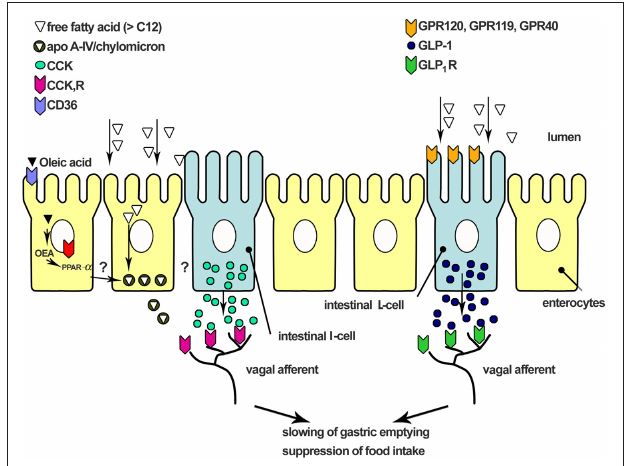
Figure 1 | Schematic representation of the mechanisms involved in small intestinal fat sensing. Fatty acids are sensed by G-protein coupled receptors (e.g., GPR40, GPR120, and GPR119) located on enteroendocrine cells. These GPCRs appear to mediate gut peptide secretion induced by small intestinal fatty acids. Uptake of fatty acids into the enterocyte is mediated by the receptor CD36. This receptor is critical for the mobilization of oleoylethanolamine (OEA), which has been shown to reduce food intake and body weight via the activation of the nuclear receptor, peroxisome-proliferator- activated receptor- α (PPAR- α ). Long chain fatty acids also stimulate chylomicron formation, and, in particular, the chylomicron component apolipoprotein A-IV (apo A-IV), is important in mediating CCK secretion and the effects of long-chain fatty acids on energy intake. The gut peptides released, such as CCK and GLP-1, interact with receptors on vagal afferent nerve terminals within the intestinal wall to convey signals to the brainstem and higher brain centers, resulting in changes in gastrointestinal function and the suppression of food